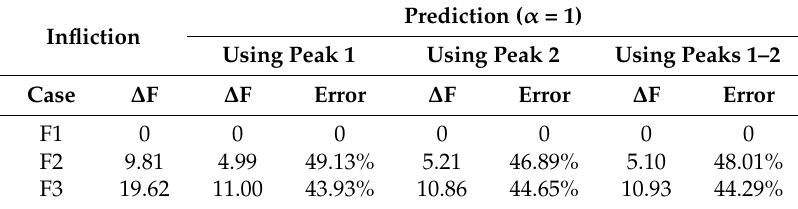
Table 8. Prediction of tension force changes (kN) in lab-scale cable